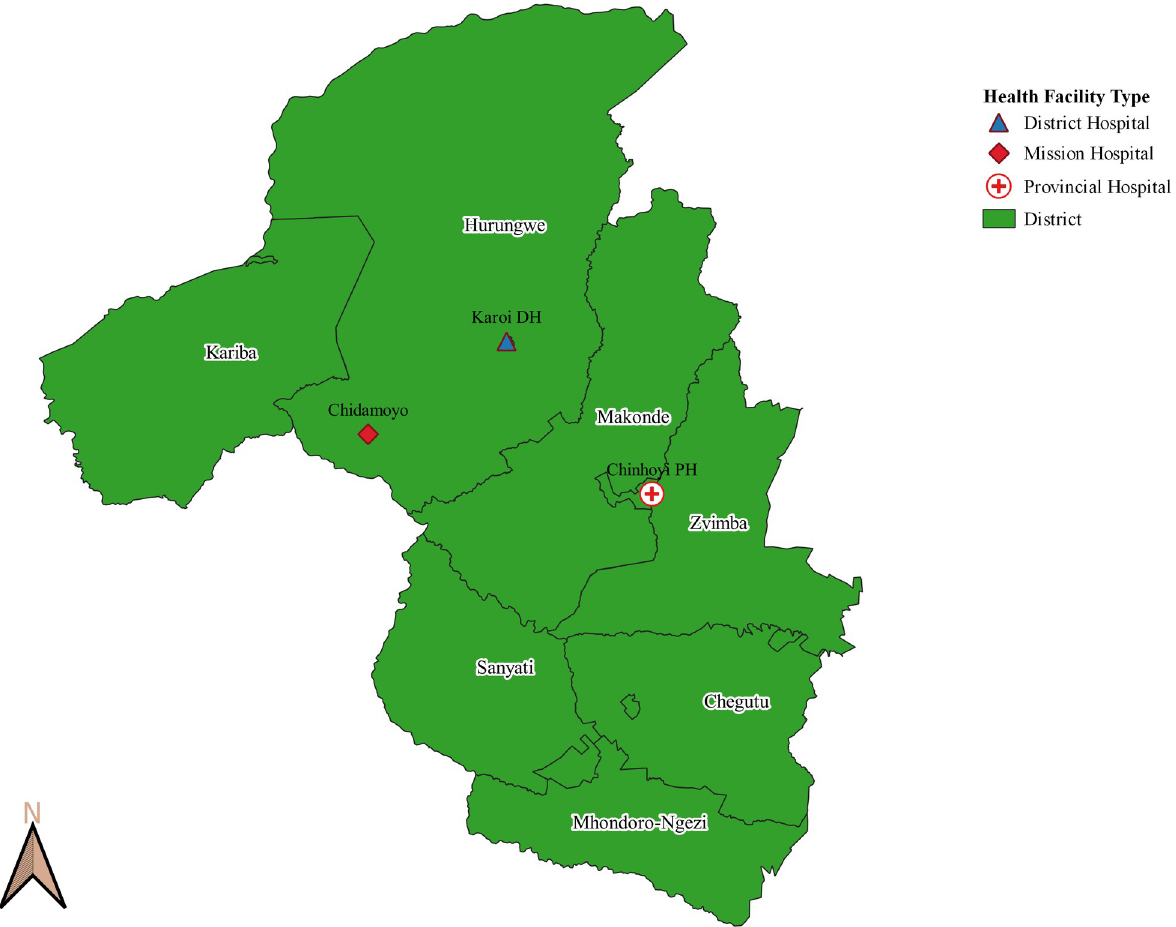
Fig 1. Map of study area with referral facilities marked. Reprinted under a CC BY license, with permission from Brighton Gambinga, original copyright 2020.